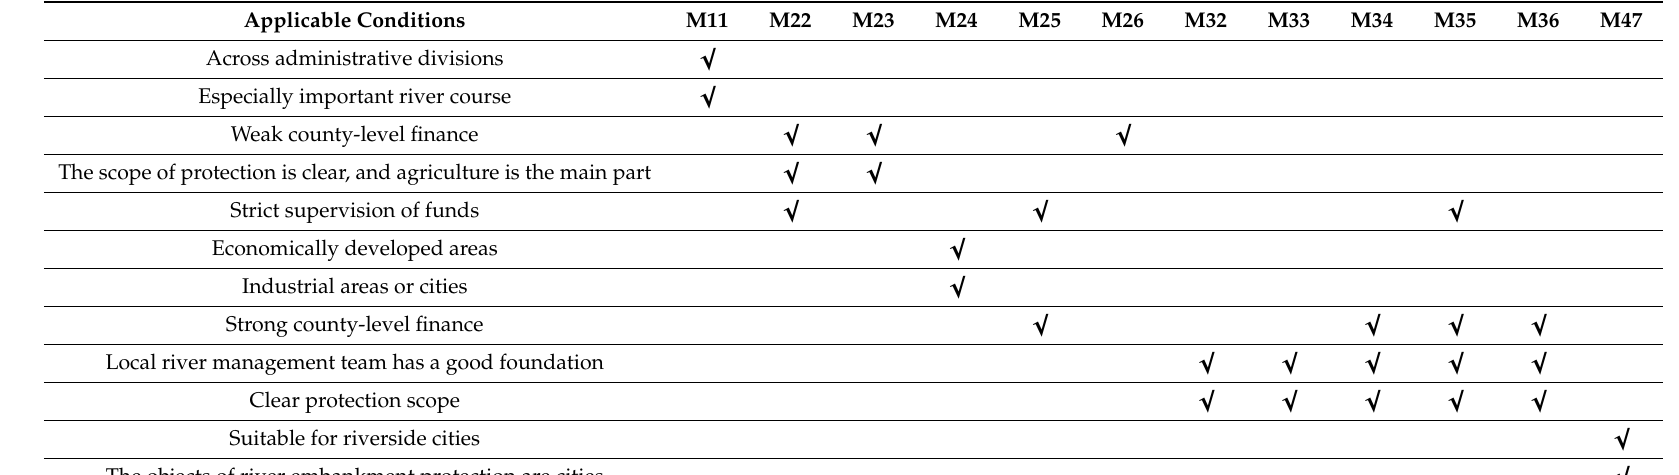
Table A4. Comparisons of river operation management modes’ applicable